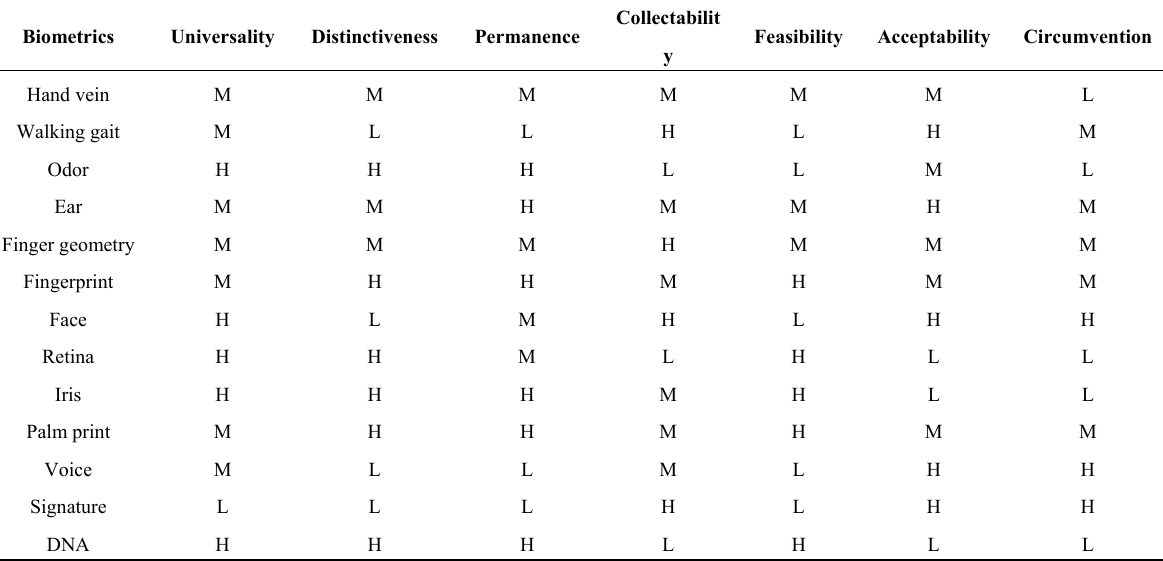
Table 1. Comparison of various biometric technologies’